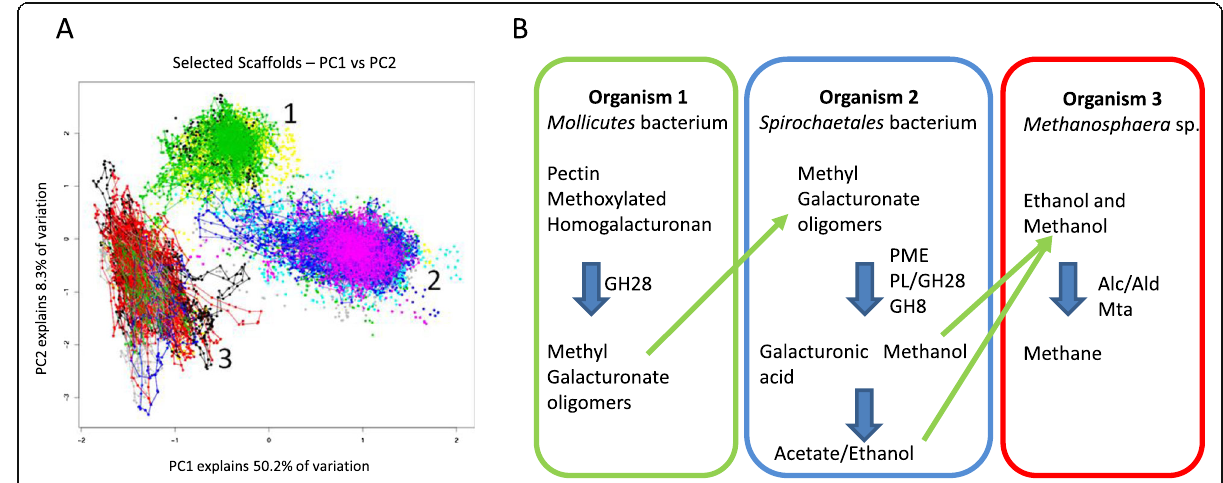
Fig. 3 a : Tetranucleotide plot of the 24 scaffolds defining the 3 organisms recovered from a pectin-utilising, methane-producing enrichment culture. b : Predicted metabolic relationship between the three organisms enabling pectin conversion to